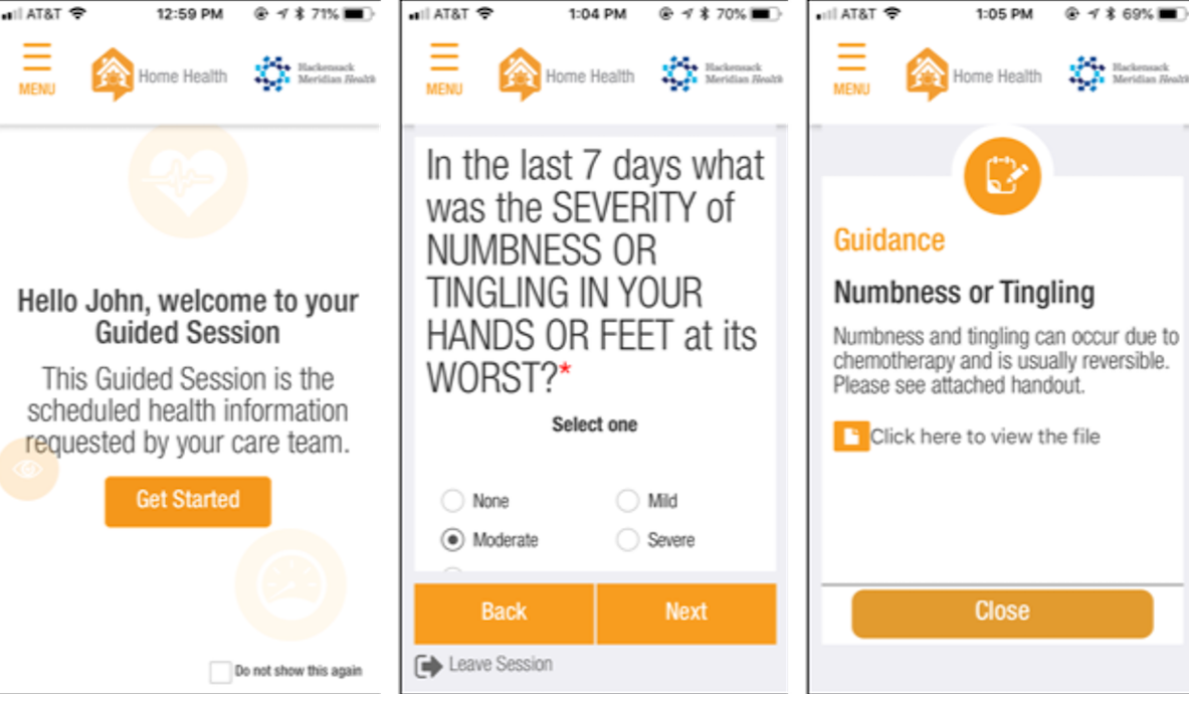
Figure 1. Screenshots of the Medocity Home Health